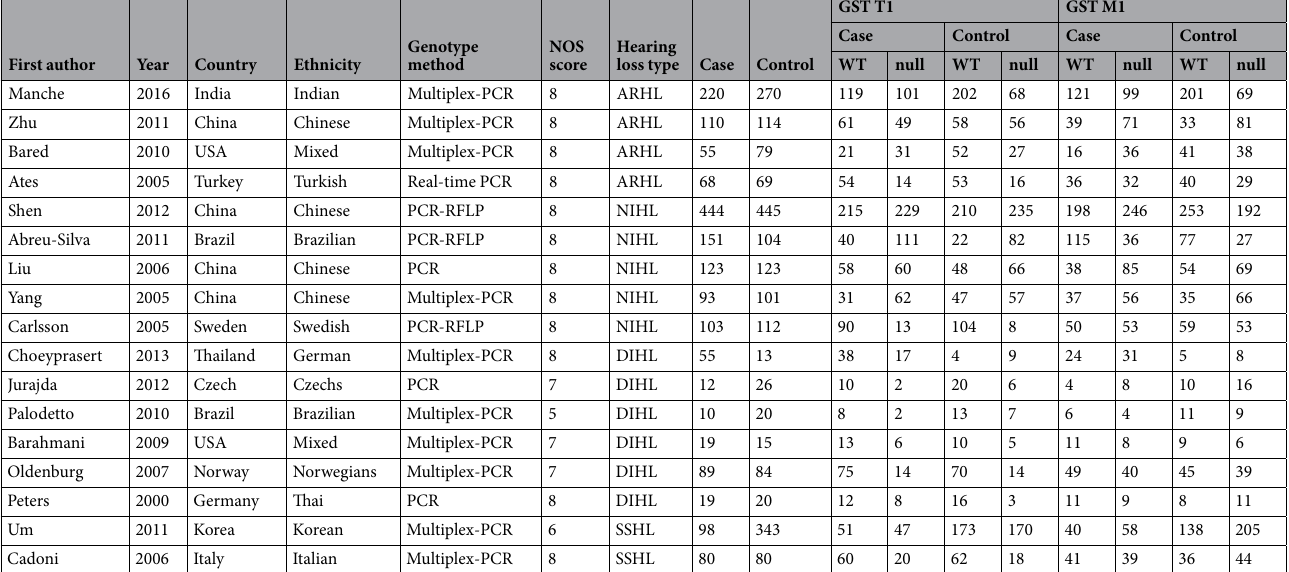
Table 1. Characteristics of included studies. NOS: Newcastle-Ottawa Scale. GST: glutathione s-transferase. ARHL: age-related hearing loss. NIHL: noise-induced hearing loss. DIHL: drug-induced hearing loss. SSHL: sudden sensorineural hearing loss. WT: wild type. PCR-RFLP: polymerase chain reaction-restriction fragment length polymorphis.